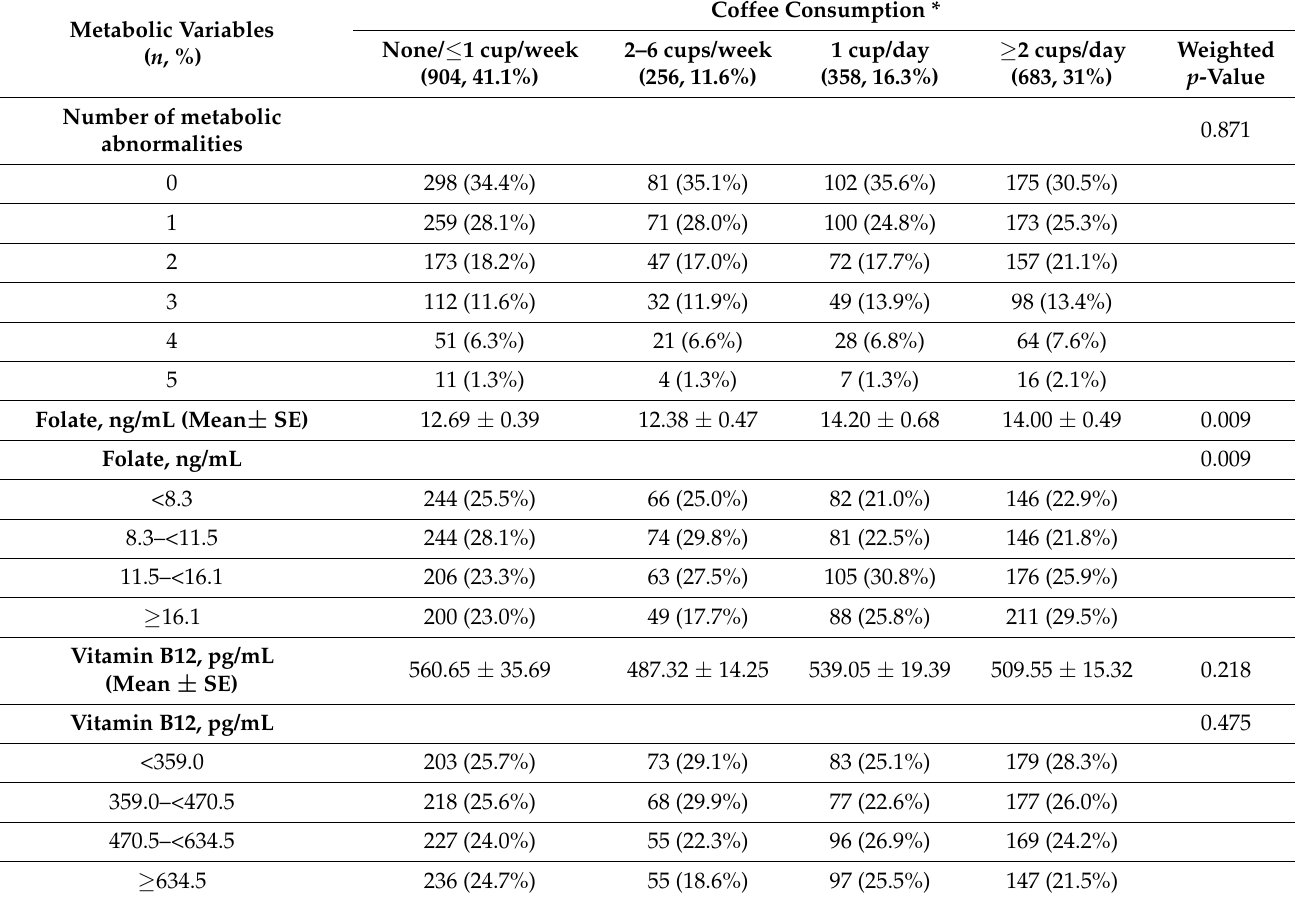
(Table 3, normal: p = 0.27; overweight: p = 0.96, obese: p =